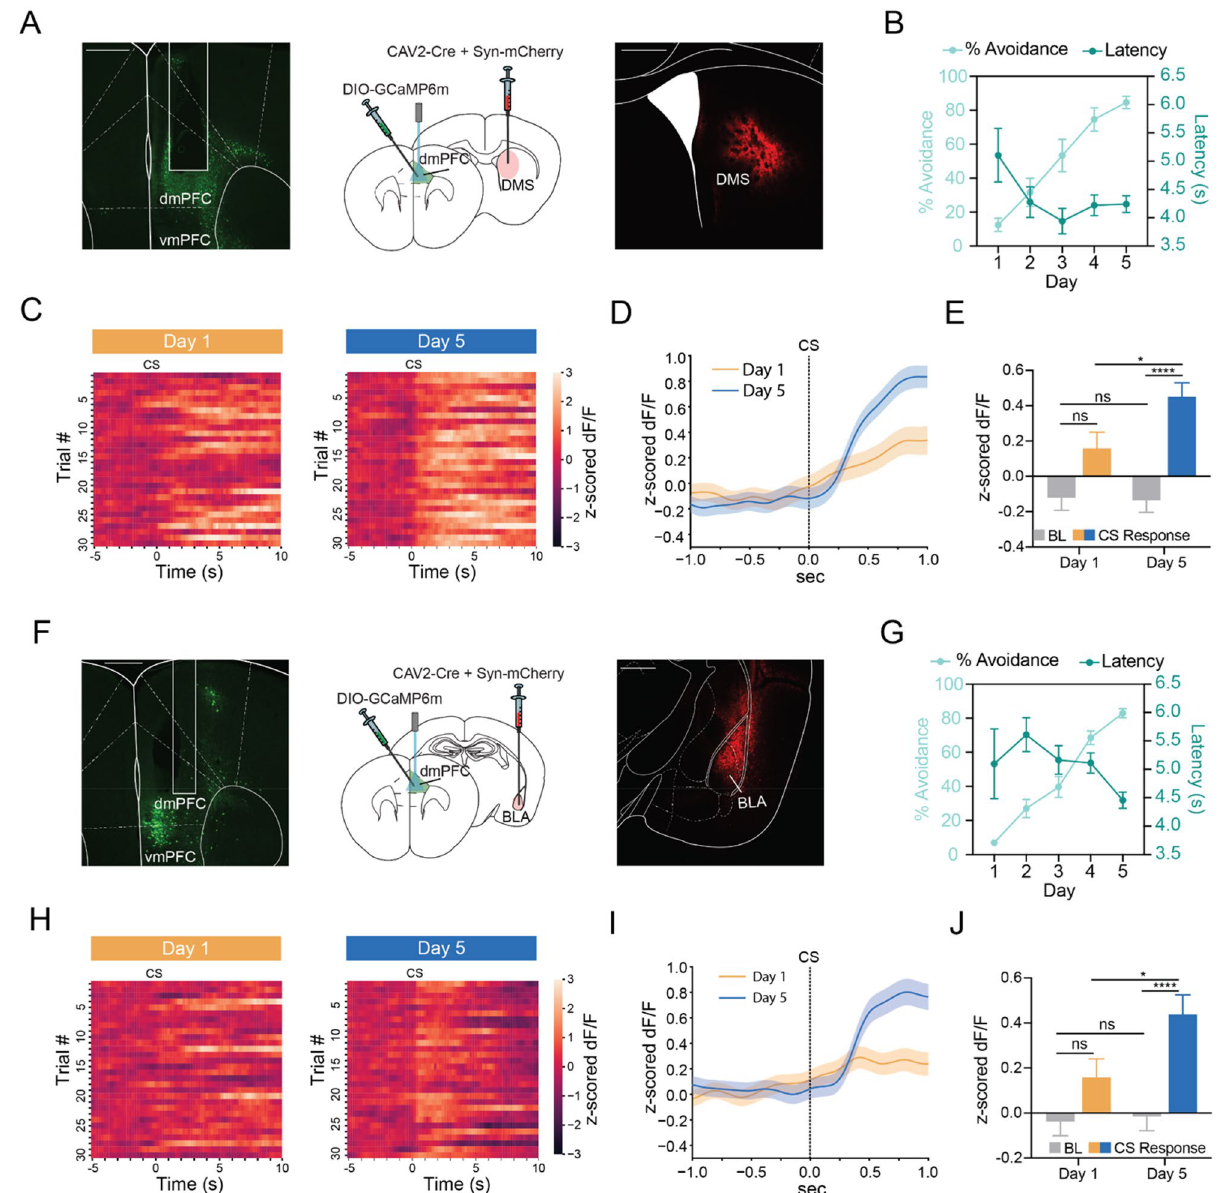
Figure 3. dmPFC-DMS and dmPFC-BLA projections show similar learning-related increases in activity at CS onset during active avoidance learning. ( A ) Viral targeting strategy for dmPFC-DMS photometry along with representative histological image of fiber photometry implant and GCAMP viral expression in dmPFC (left) and CAV2-Cre + mCherry viral expression in the DMS (right). Scale bar 500 µm. ( B ) Percent avoidance increases while avoidance latency decreases across training in the dmPFC-DMS cohort. ( C ) Heatmaps of change in calcium signal aligned to CS onset for each of the 30 trials arranged from first to the last trial for Day 1 (left) and Day 5 (right). dmPFC-DMS projection shows sustained increases in calcium signal at CS onset that become more consistent across training. ( D ) PETH shows increases in signal at CS onset in the dmPFC-DMS projection following training. orange line, mean ± SEM for Day 1; blue line, mean ± SEM for Day 5. ( E ) Quantification of the dmPFC-DMS CS onset PETH shows significant increase in calcium signal during the CS period (0 to 1 s) compared to the baseline period (-1 to 0 s) for Day 5, but not Day 1. ( F ) Viral targeting strategy for dmPFC-BLA photometry along with representative histological image of fiber photometry implant and GCAMP viral expression in dmPFC (left) and CAV2-Cre + mCherry viral expression in the BLA (right). Scale bar 500 µm. ( G ) Percent avoidance increases while avoidance latency decreases across training in the dmPFC-BLA cohort. ( H ) Heatmaps of change in calcium signal aligned to CS onset for each of the 30 trials arranged from first to the last trial for Day 1 (left) and Day 5 (right). dmPFC-BLA projection shows transient increases in calcium signal at CS onset only during later stages of training. ( I ) PETH shows increases in signal at CS onset in the dmPFC-BLA projection following training. orange line, mean ± SEM for Day 1; blue line, mean ± SEM for Day 5. ( J ) Quantification of the dmPFC-BLA CS onset PETH shows significant increase in calcium signal during the CS period (0 to 1 s) compared to the baseline period (−1 to 0 s) for Day 5, but not Day 1. ns = not significant, * p < 0.05, **** p <